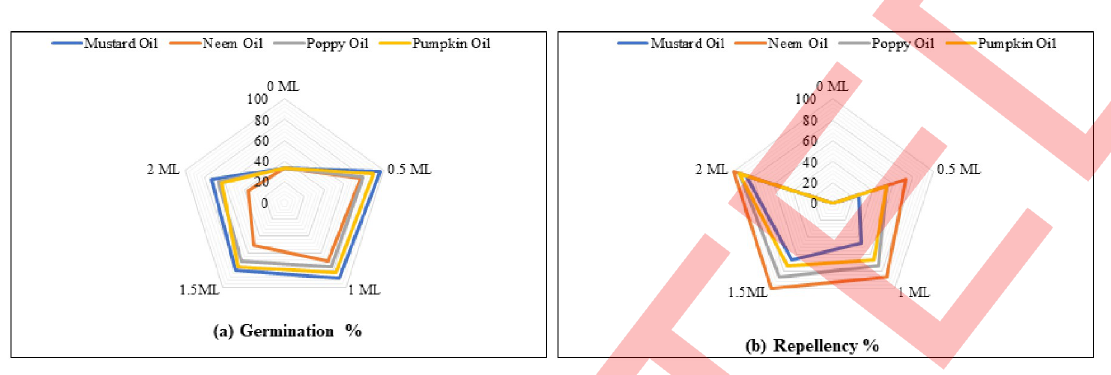
Fig 6. The impact of different botanical oils and their concentrations on germination and repellency.